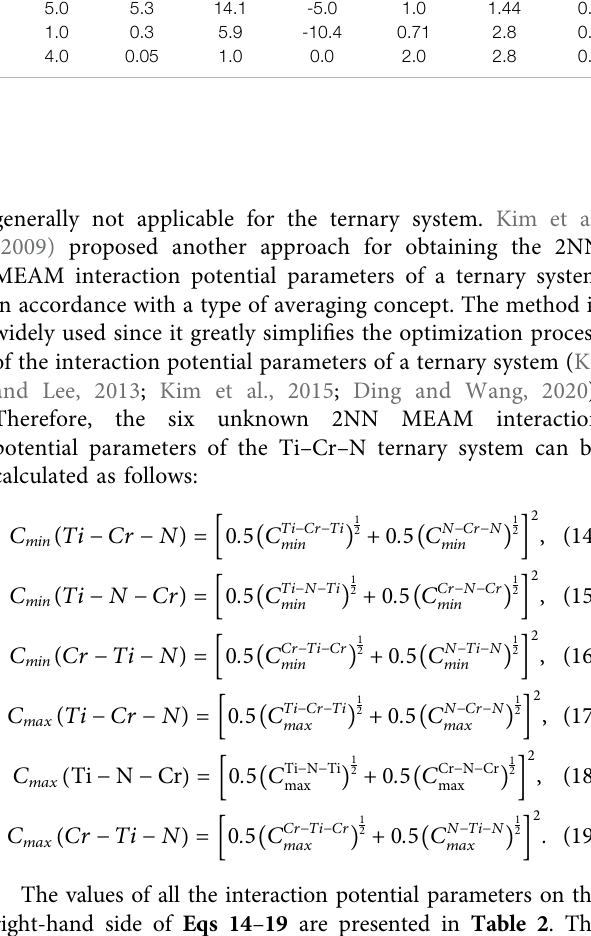
TABLE 1 | The 2NN MEAM interaction potentialparametersfor Ti, Cr and N. The units ofthe cohesive energy E c and the equilibrium nearest-neighbor distance r e are eV and Å, respectively. All the other parameters are dimensionless. The reference structures for Ti, Cr and N are hcp, fcc and dimer, respectively. E c